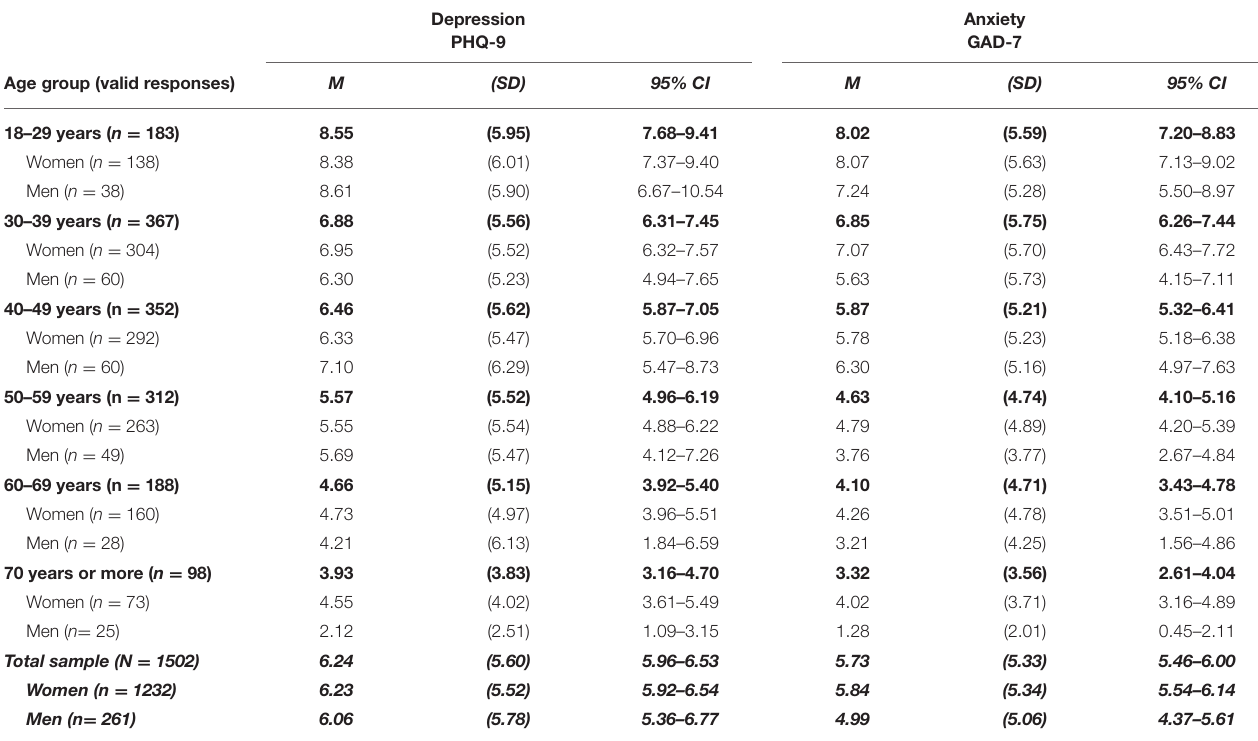
TABLE 3 | Descriptive statistics of mental health variables displayed per age group ( N = 1,503).